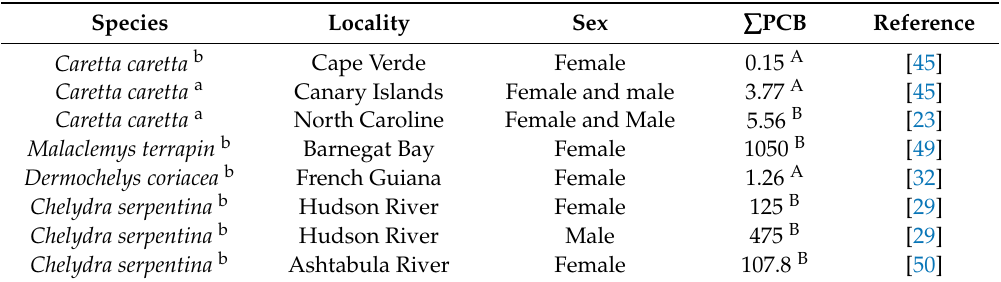
Table 3. Average PCBs concentration in blood from other